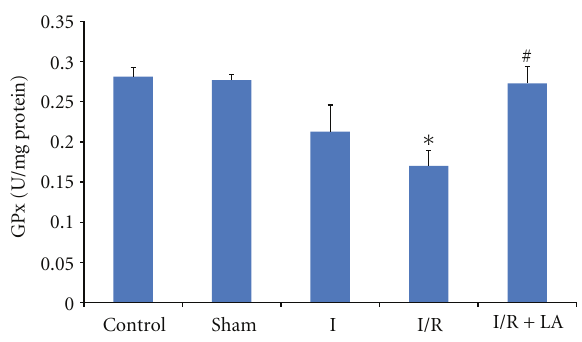
Figure 2: E ff ects of ischemia/reperfusion (2h torsion 720 ◦ in a clockwise direction and 2 h detorsion of the testis) and LA (100mg/kg ip, 30 minutes prior to detorsion) on SOD activities of rat testes. Data are mean ± SEM: ∗ P < 0 . 05 compared with control and sham groups, # P < 0 . 01 compared with I and I/R